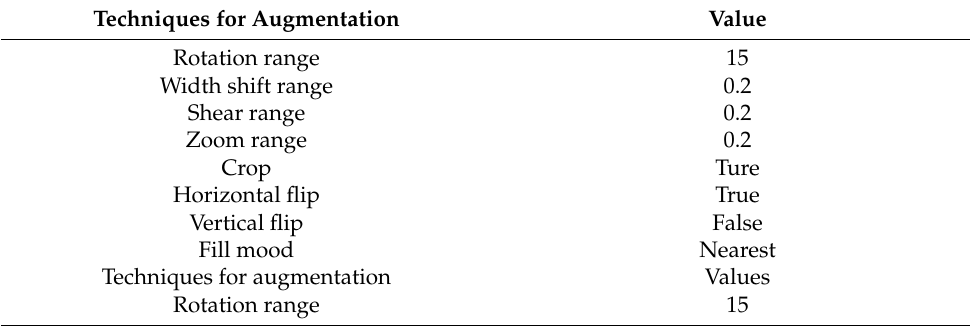
Table 3. Details of the data and the used image processing.